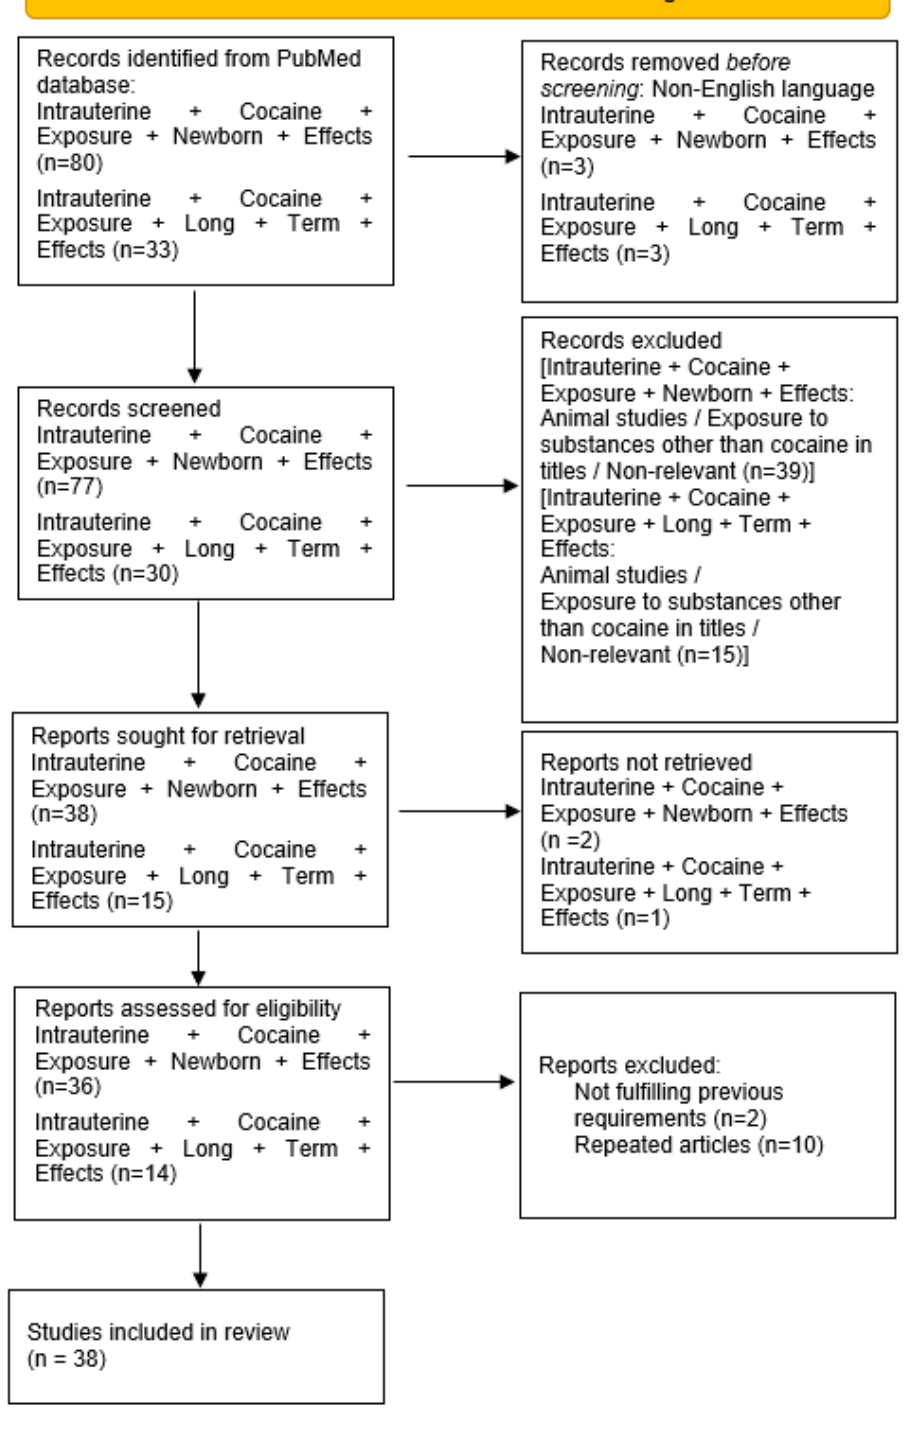
Figure 1. PRISMA flow chart [10].